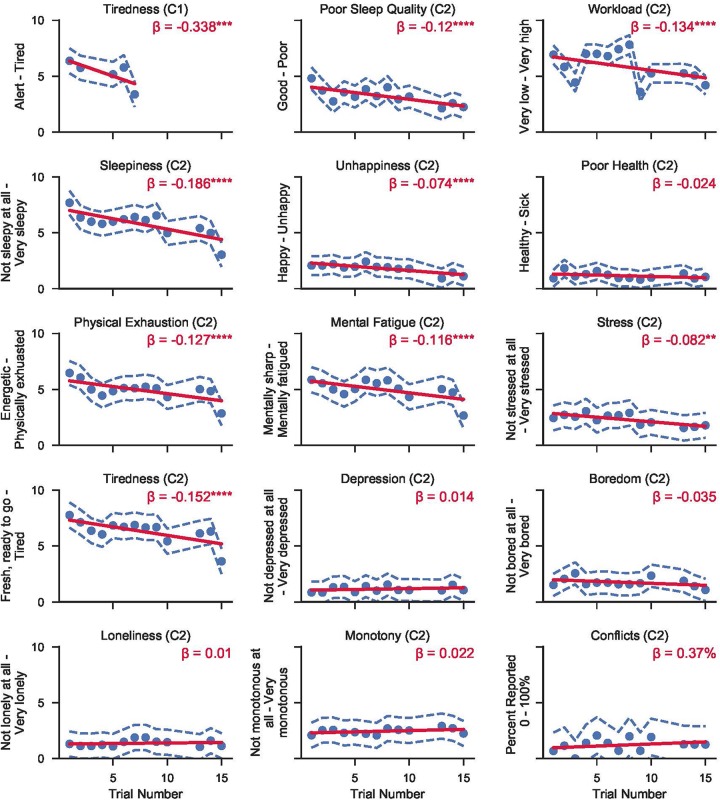
Raw (untransformed) survey response scores from the surveys administered in either campaign 1 (C1) or campaign 2 (C2) at HERA. Circles refer to the mean score across subjects from either campaign for each trial number. Dashed blue lines show the 95% CI range around each mean point. Solid red lines represent mixed effects linear models fit to the data within each question. β refers to the linear slope of the regression model (i.e., change in raw score per trial). Asterisks refer to significance levels after adjusting for multiple testing with the false discovery rate method with p-values referring to H0: regression line slope = 0. (*p < 0.05; **p < 0.01; ***p < 0.001; ****p < 0.0001).